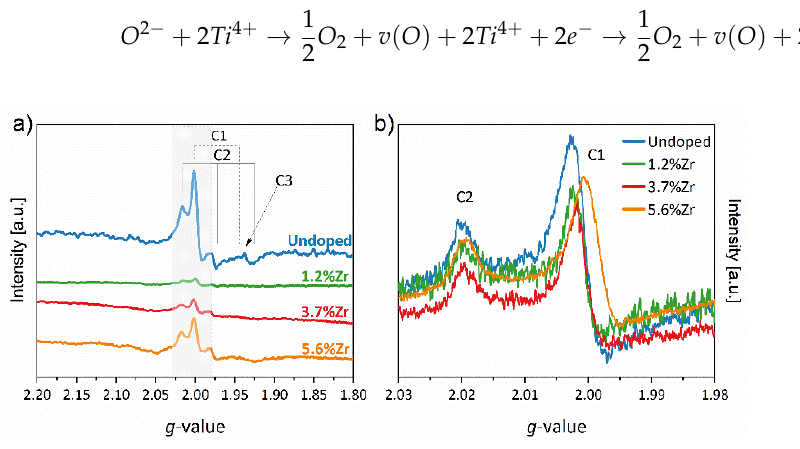
Figure 12. X-band EPR spectra ( a ) with an enlargement ( b ) recorded at 77 K with distinct three Figure 12. X ‐ band EPR spectra ( a ) with an enlargement ( b ) recorded at 77K with distinct three components.